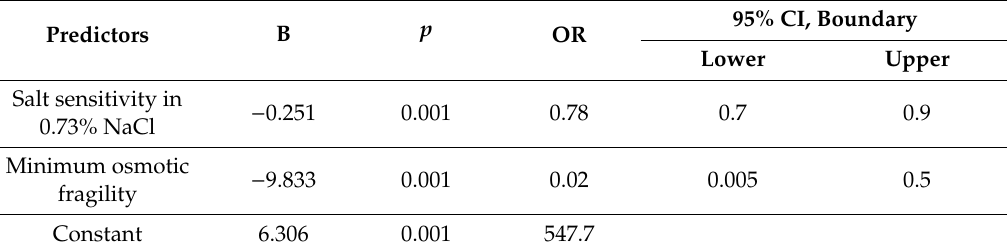
Table 3. Characteristics of the predictive model of CSVD development.